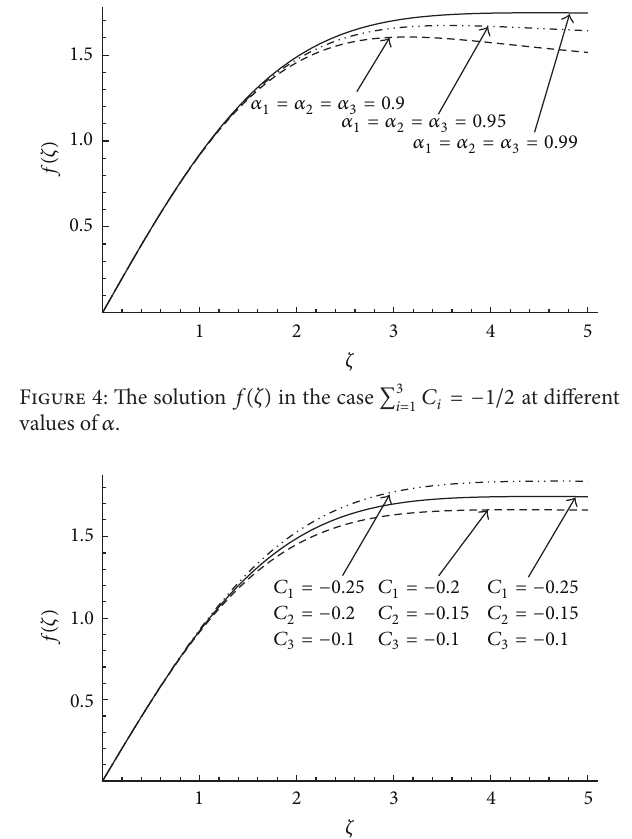
Figure 5: The solution 𝑓(𝜁) at 𝛼 1 = 𝛼 2 = 𝛼 3 = 0.99 and different values of 𝐶 𝑖 , 𝑖 = 1,2,3